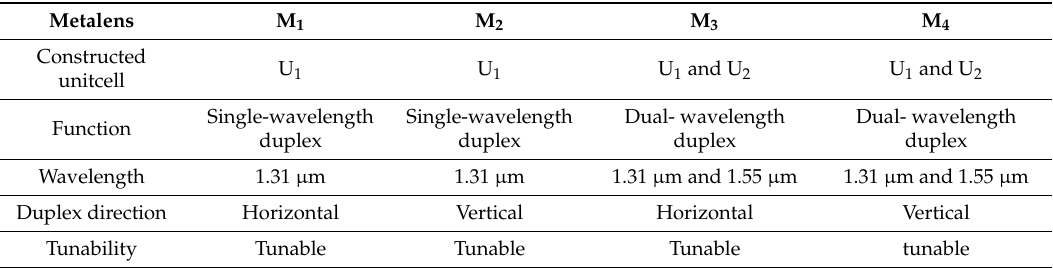
Table 1. Comparison of the four